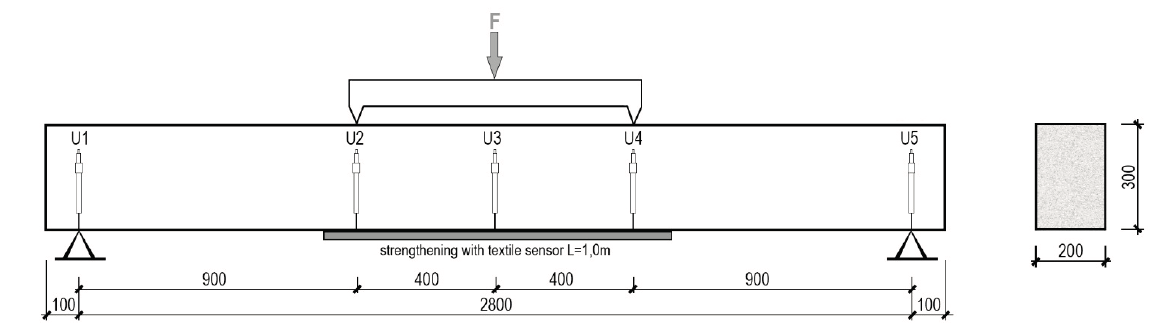
Figure 5. Scheme of the laboratory stand for loading test of reinforced concrete (RC) beams strengthened with textile